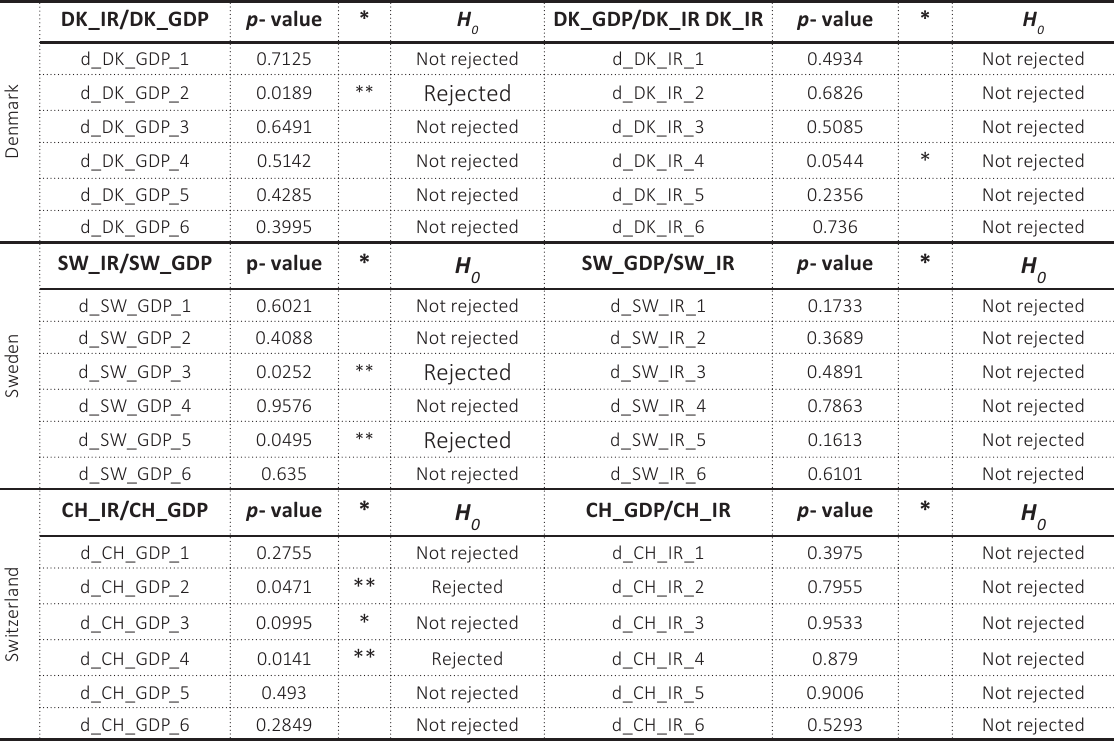
Table 10. The results of the Granger causality test for interest rates and blue chip stock indices